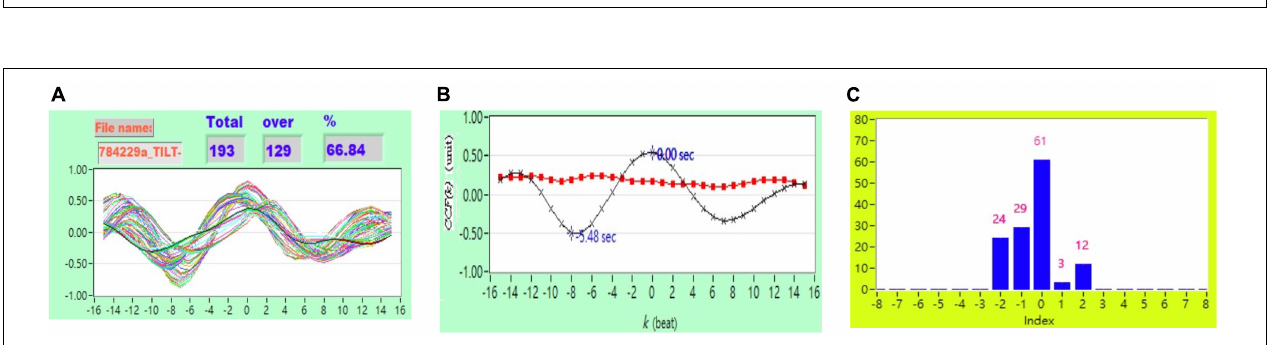
FIGURE 2 | (A) Representative plot of all CCF curves without thresholding, (B) mean CCF value ( x ) and SD ( (cid:4) ), and (C) distribution bar chart of maximum CCF index during tilt in a healthy subject.